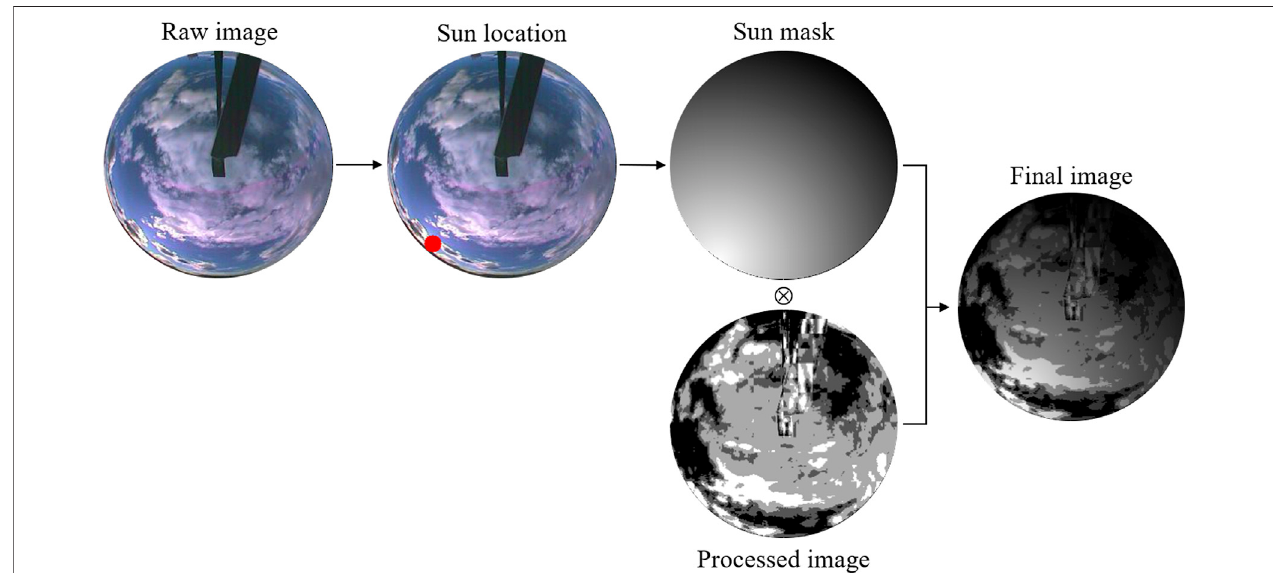
FIGURE 7 | Pictorial representation of the process for merging the sun mask with preprocessed image output.